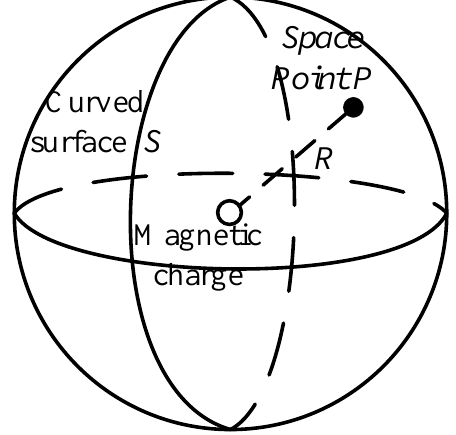
Figure 3. Magnetic calculation model.